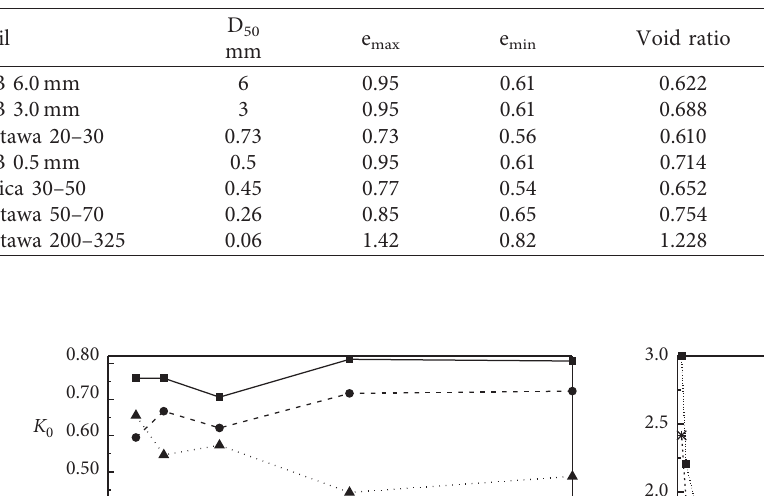
Table 1: Physical properties of the tested materials.